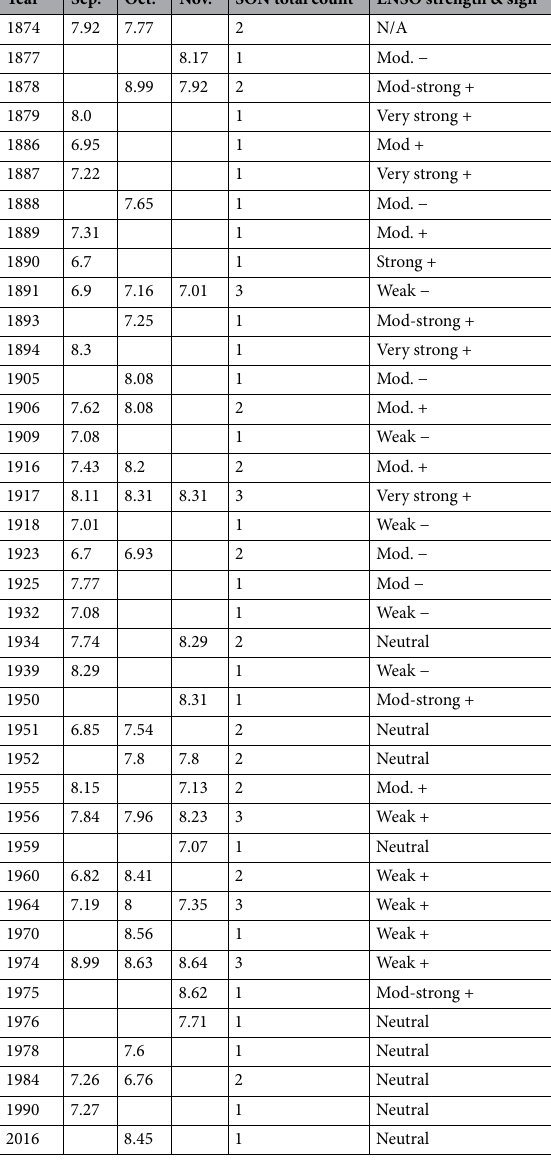
Table 2. Table showing spring (SON) weekly maximum Murrumbidgee river heights at Hay (southern MDB) that exceed flood level (6.7 m), and seasonal count, in the 125 years 1874–2018. Also included is the strength of the ENSO signal as determined by the Australian Bureau of Meteorology (http:// www. bom. gov. au/ clima te/ enso/ lnlist/ index. shtml). Note the neutral ENSO association with flood heights since the mid-1970s and only one event since